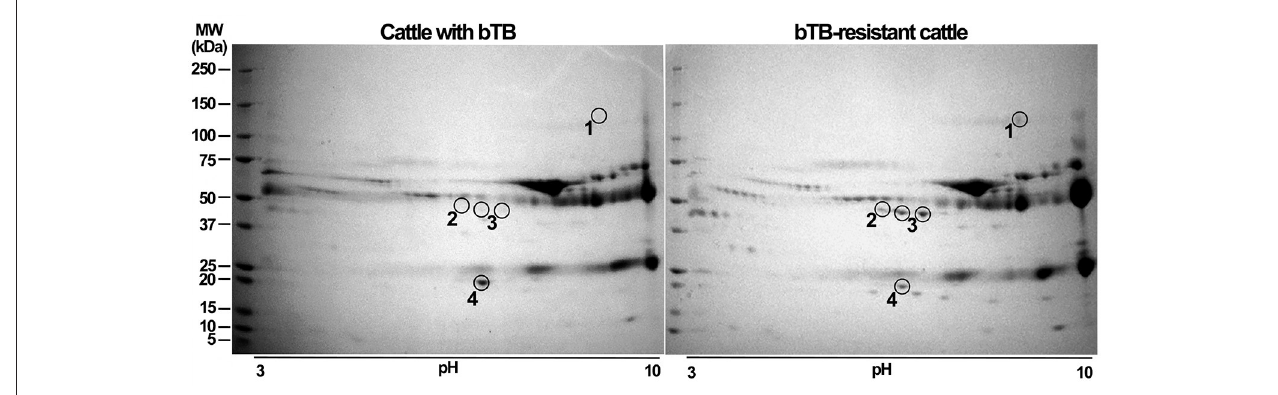
FIGURE 2 | Resolving fractions of sera by two-dimensional gel electrophoresis (2D-GE) enhances detection and precise excision of overexpressed proteins of susceptible and resistant cattle. Offgel fractions 2, 4, 6, 8, and 10 of sera from bTB-susceptible and bTB-resistant cattle were independently pooled, cleaned, separated by 2D-GE and stained with Coomassie blue. A comparative analysis of protein amount was implemented using PDQuest 2-D software. Proteins with significant differences ( p < 0.05, Student’s t-test) were excised and processed for LC/ESI-MS/MS analysis. We show a representative two-dimensional gel of proteins from bTB-susceptible cattle and one of that of bTB-resistant cattle. Proteins differentially expressed among gels are enclosed in circles and numbered. Encircled protein spots close to number 3 correspond to the same protein, but with a different isoelectric point. Protein molecular weight markers (M) were ran along the samples to determine the relative molecular weight of